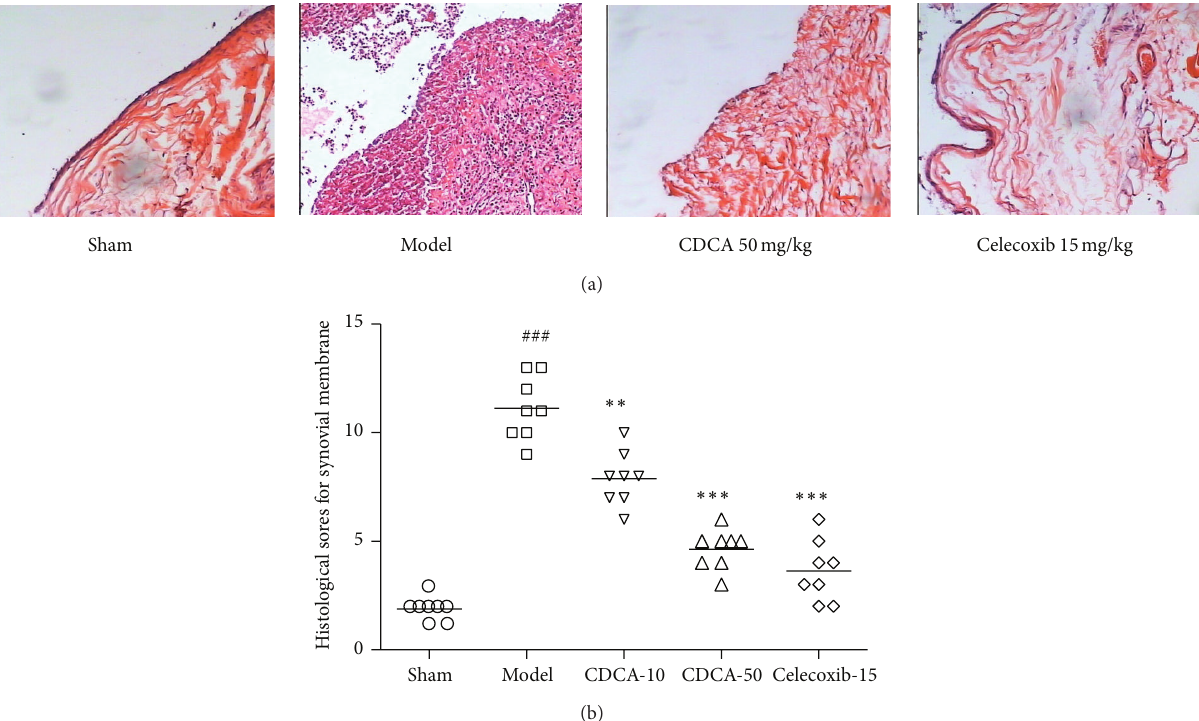
Figure 3: (a) Representative hematoxylin-eosin (HE) stained sections of synovial membrane are shown. Magnification 100x. (b) Histological sores for synovial membrane in the five groups of experimental rabbits. Results are presented as individual data points and the median for each group is indicated by a horizontal bar. ### 𝑃 < 0.001 , compared with the sham-operation group; ∗∗ 𝑃 < 0.01 , ∗∗∗ 𝑃 < 0.001 , compared with the model group. Similar results were observed in two separated experiments.